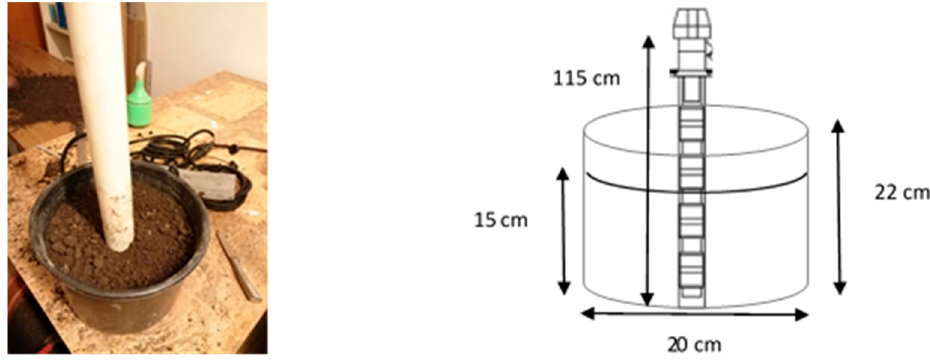
Figure 3. Schematic of the experimental laboratory setup.